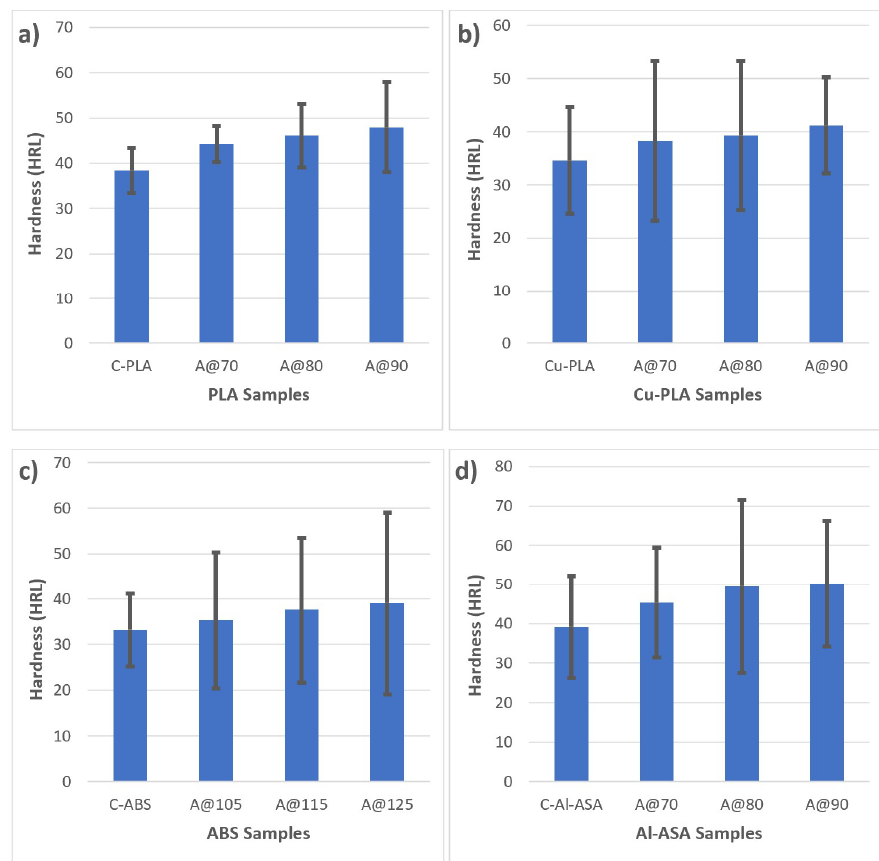
Figure 18. Hardness test results for the four materials; ( a ) PLA material; ( b ) Cu-PLA material; ( c ) ABS material; ( d ) Al-ASA material.